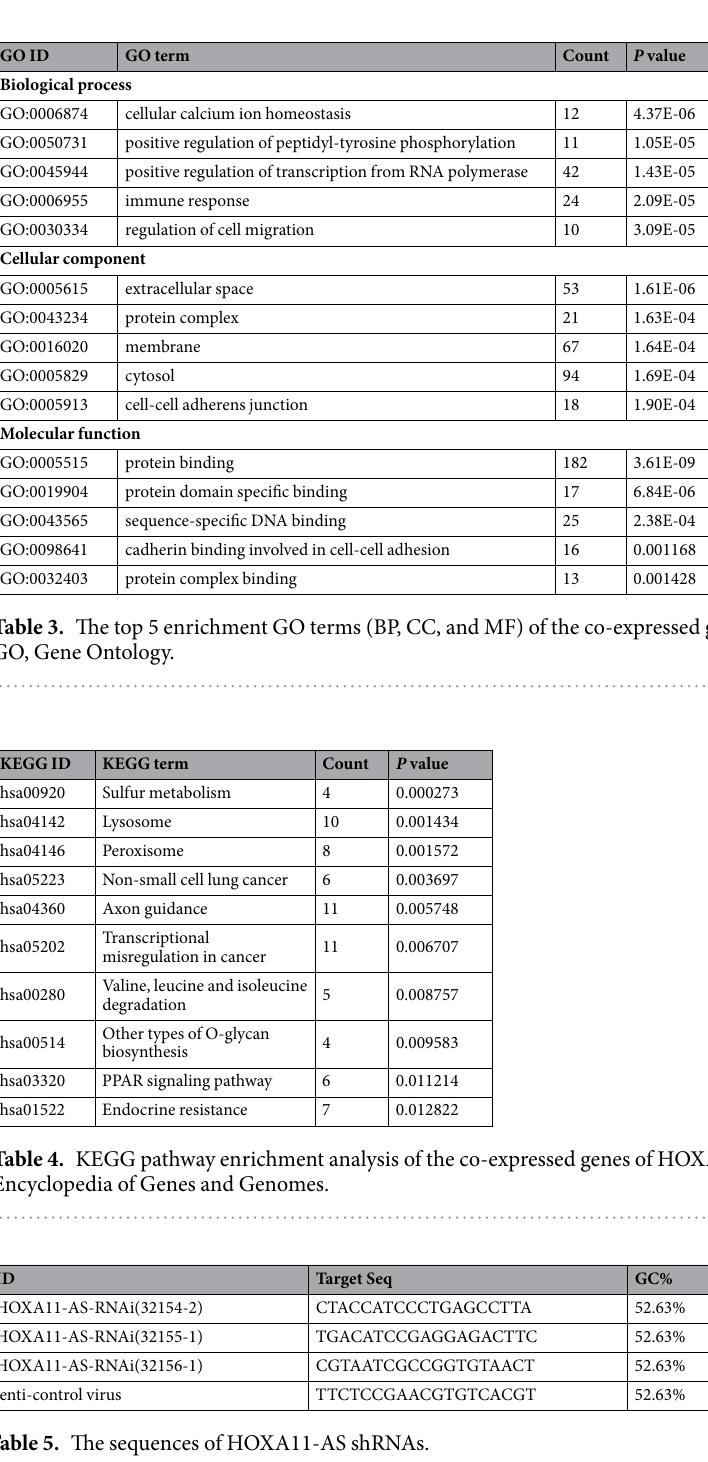
Exploration of the effect of HOXA11-AS on biological processes in NSCLC.